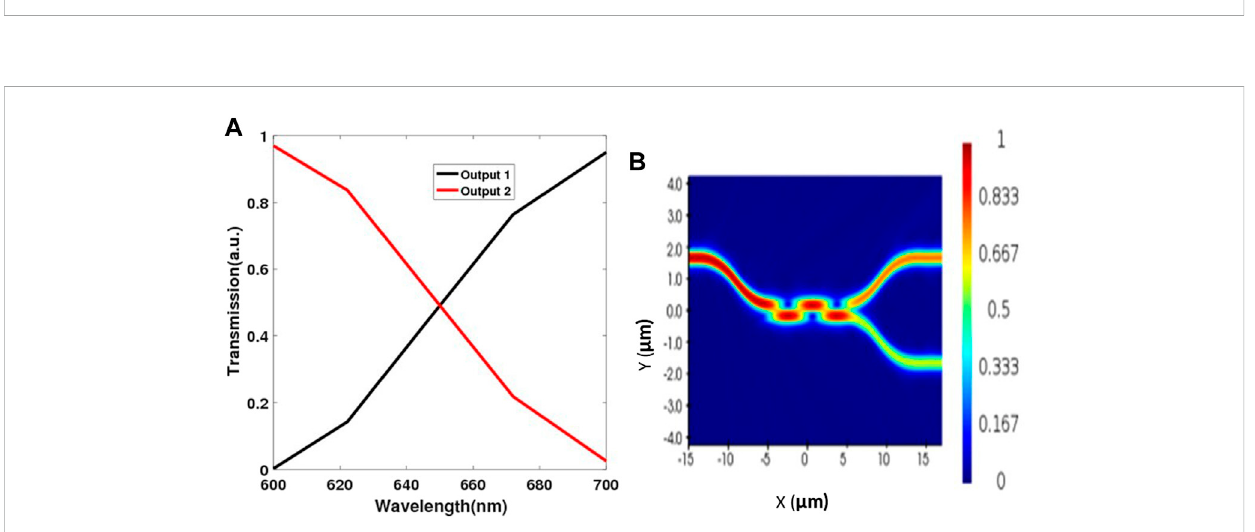
FIGURE 2 (A) The transmission of the two output arms of the DC versus wavelength. (B) Field pro fi le in the DC at a wavelength of 650